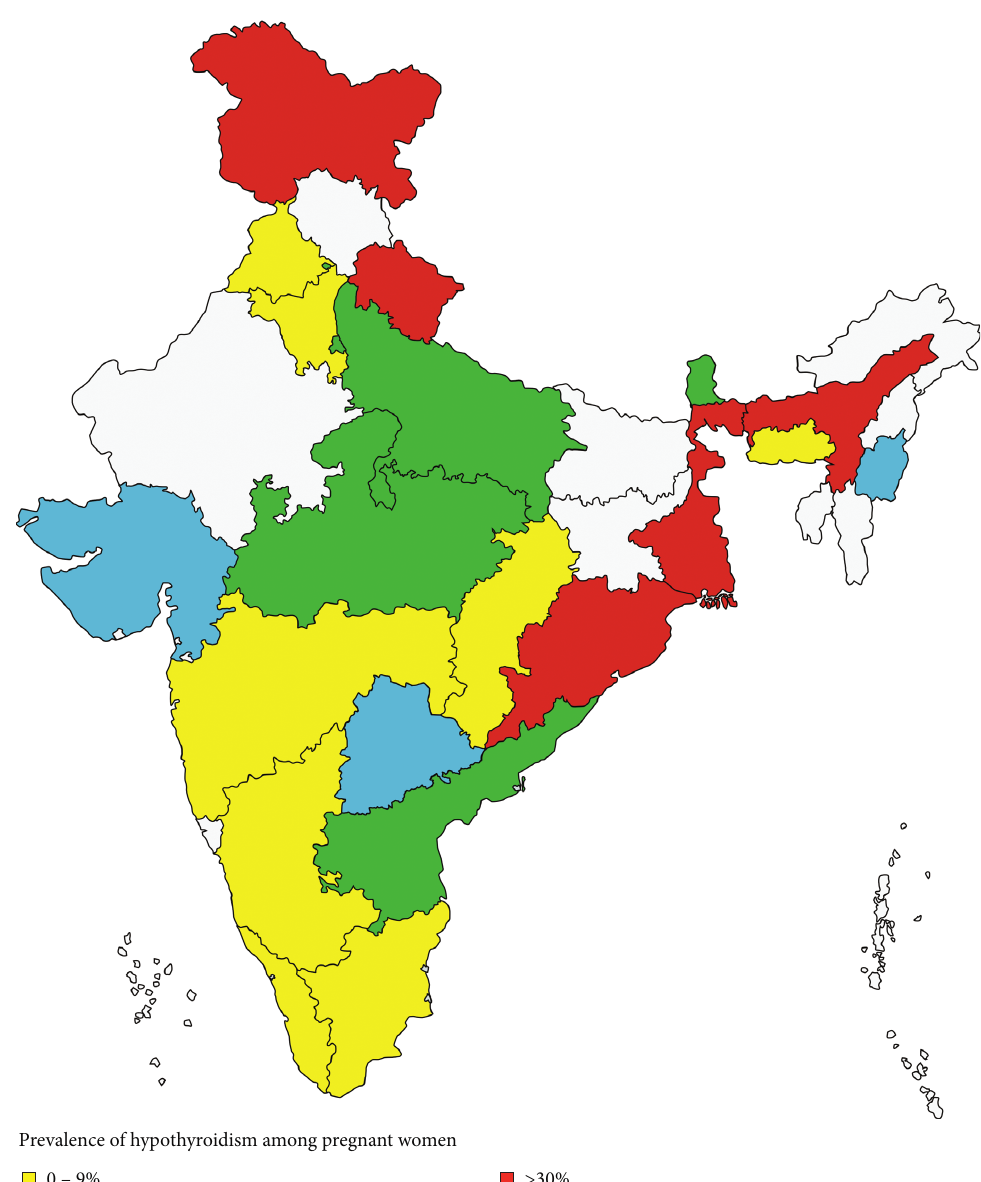
Figure 5: Distribution of hypothyroidism across various states of India.